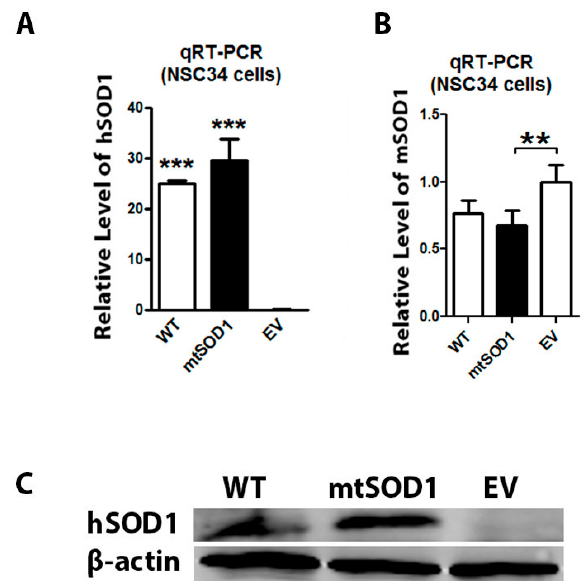
Figure 1. mRNA and protein expression of human SOD1 and mouse SOD1 in NSC34 cells. ( A ) The mRNA expression of human SOD1 (hSOD1) was detected by qRT-PCR in wild type (WT) SOD1 NSC34 cells and mutant SOD1 (mtSOD1) NSC34 cells, but was not detectable in empty vector (EV) NSC34 cells; ( B ) The mRNA level of mouse SOD1 (mSOD1) was detected by qRT-PCR in WT SOD1 NSC34 cells, mtSOD1 NSC34 cells, and EV NSC34 cells; ( C ) hSOD1 protein expression was measured by Western blot in WT SOD1 NSC34 cells, mtSOD1 NSC34 cells, and EV NSC34 cells. ** p < 0.01 vs. EV group, *** p < 0.001 vs. EV group. n = 3 independent batches of cells for each group.